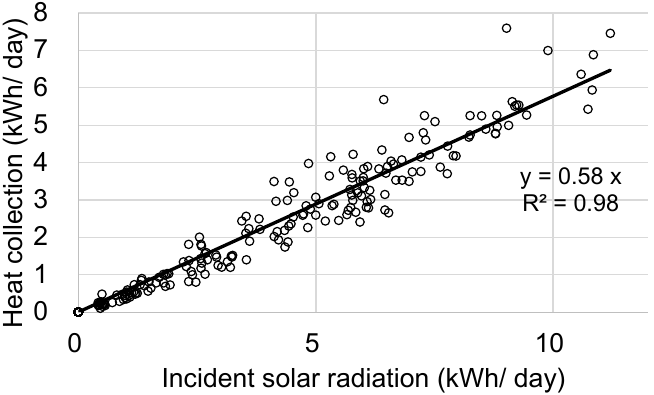
Figure 9. Relationship between incident solar radiation and heat collection.